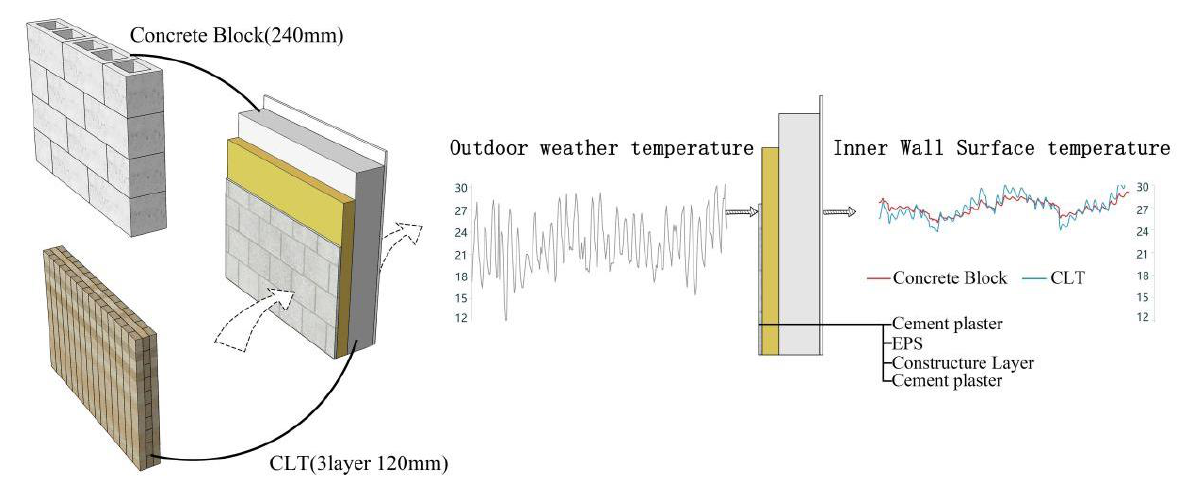
Figure 4. Schematic diagram of building structure simulation.